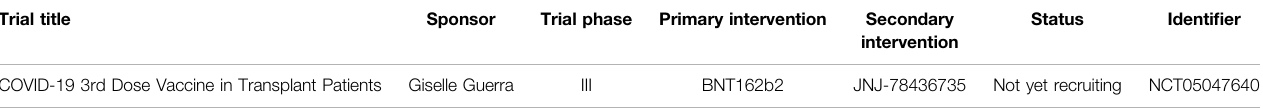
TABLE 12 | Summary of clinical trials of JNJ-78436735 vaccine (produced by Johnson and Johnson/Janssen) on COVID-19